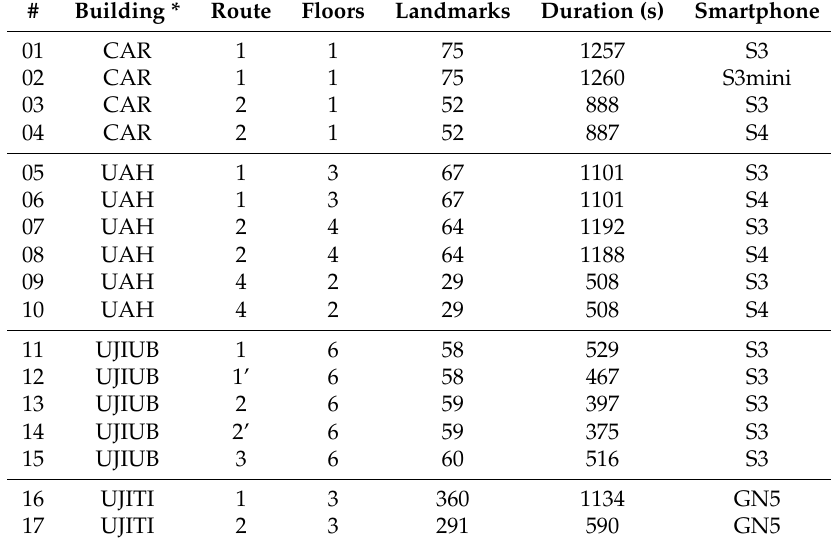
Table 1. Description of the training